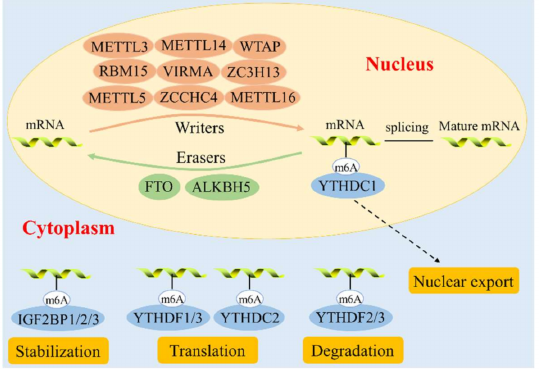
Figure 1. The molecular mechanism of m6A methylation. The methylation of m6A is regulated by m6A methyltransferase, including METTL3, METTL14, WTAP, RBM15, VIRMA, ZC3H13, METTL5, ZCCHC4, and METTL16. FTO and ALKBH5 are demethylases that carry out demethylation. m6A binding proteins, such as YTHDF1/2/3 and YTHDC1/2, recognize specific binding sites to perform a variety of biological functions such as stabilization, translation, and degradation of